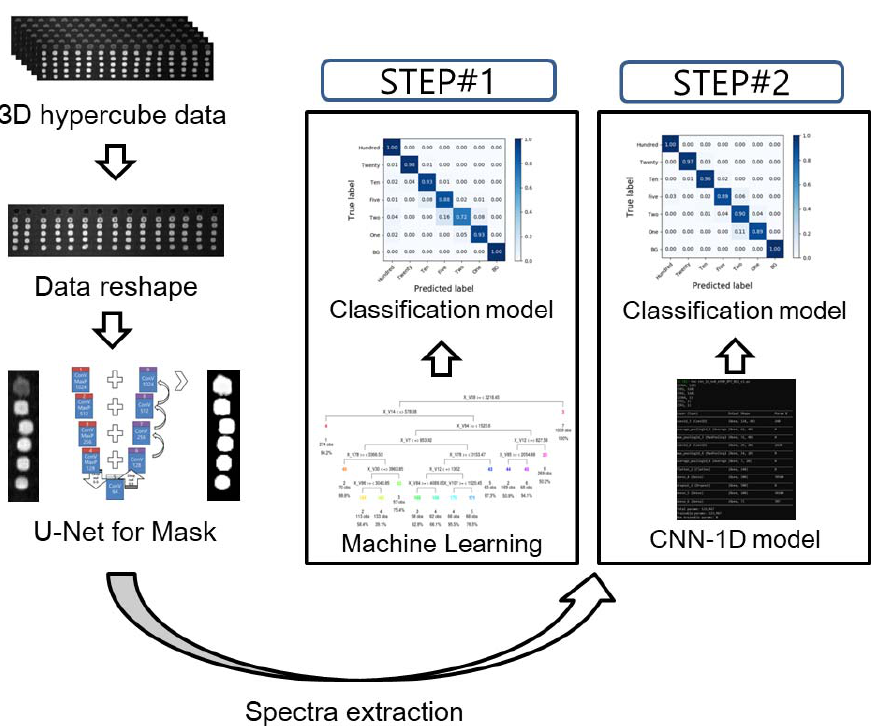
Figure 1. Flow chart of the data processing and schematic architecture of a 1D convolutional neural network. In order to develop the classification model, STEP#1 is using chemometric methods and STEP#2 is using the CNN-1D algorithm.